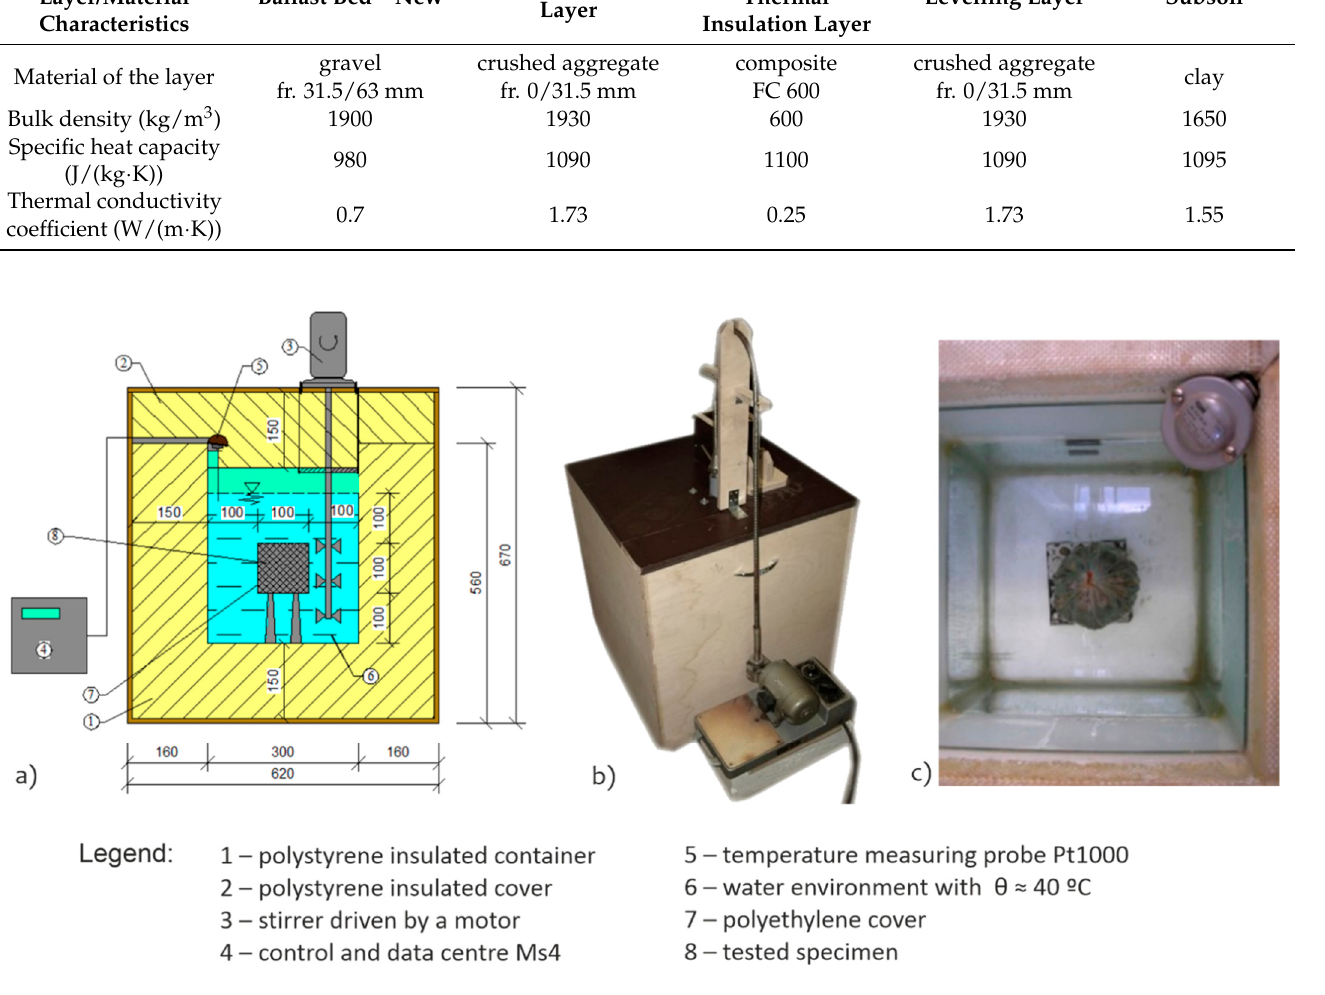
Table 2. Properties of material layers and subsoil.